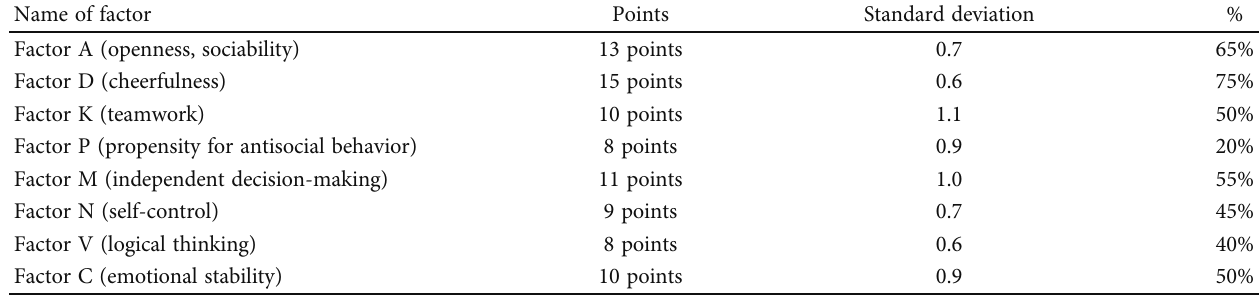
Table 3: Final results.